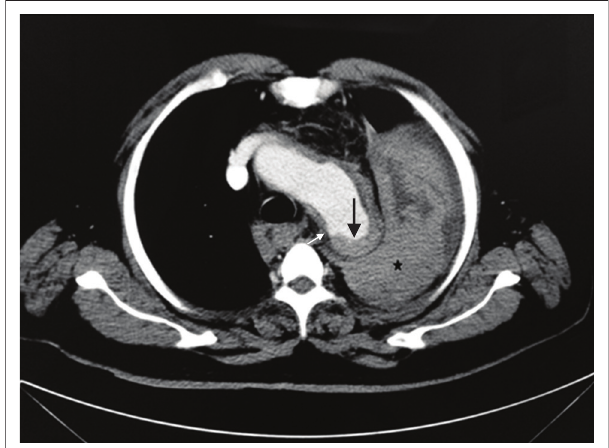
FIGURE 10: Ruptured penetrating atherosclerotic ulcer (PAU) with contained haematoma. Contrast-enhanced computed tomography scan of thorax showing a ruptured PAU along the posterior aortic wall (white arrow) with adjacent intramural haematoma (black arrow) appearing as hyperdense aortic wall thickening and a contained haematoma in left pleural space ( * ). Findings were confirmed at